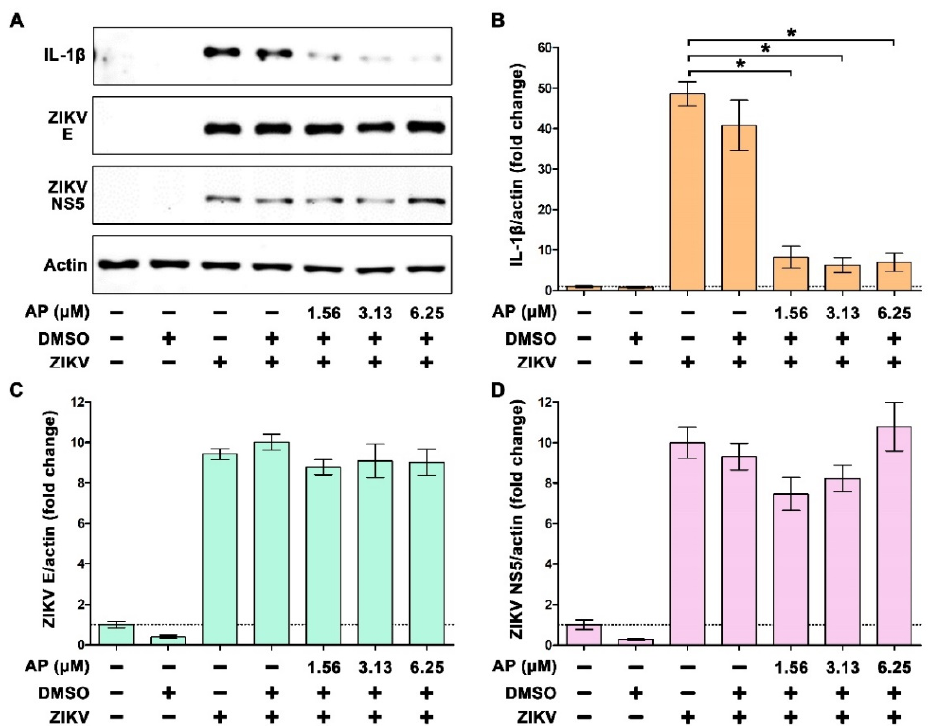
Figure 5. Western blot analysis examining the effects of AP on intracellular production of IL-1 β , ZIKV E protein, and ZIKV NS5 protein in THP-1 macrophages infected with ZIKV at 5 MOI for 48 h. ( A ) Immunoreactive bands of IL-1 β , ZIKV E protein, and ZIKV NS5 protein in the lysates of THP-1 macrophages infected with ZIKV at 5 MOI with or without post-treatment with AP at various concentrations (1.56, 3.13, and 6.25 µ M). ( B ) Densitometric quantification of IL-1 β immunoreactive bands. ( C ) Densitometric quantification of ZIKV E protein immunoreactive bands. ( D ) Densitometric quantification of ZIKV NS5 protein immunoreactive bands. Actin was used as an internal control and for normalization. * p < 0.05 compared to ZIKV-infected group. Densitometry scans and uncropped blots are presented in Supplementary Materials.